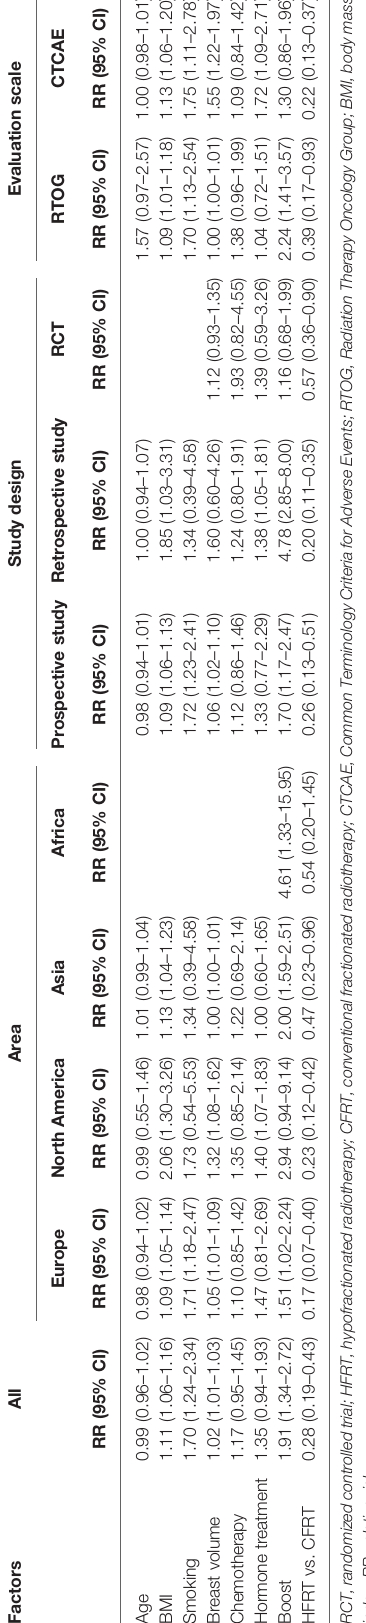
Supplementary Figure 1 | Begg ’ sfunnelplotofpatients-relatedriskfactorsassociated withacuteradiationdermatitis. (A) Age; (B) BMI; (C) breastvolume; (D) smoking. Supplementary Figure 2 | Begg ’ s funnel plotof treatment-related riskfactors associatedwithacuteradiationdermatitis. (A) boost; (B) hypofractionatedradiotherapy (HFRT) vsconventional fractionated radiotherapy (CFRT); (C) chemotherapy regimen; (D) hormone therapy. Supplementary Figure 3 | Sensitivity analysis of the effect ofpatients-related risk factorsassociatedwithacuteradiationdermatitis. (A) Age; (B) BMI; (C) breastvolume; (D) smoking. T A